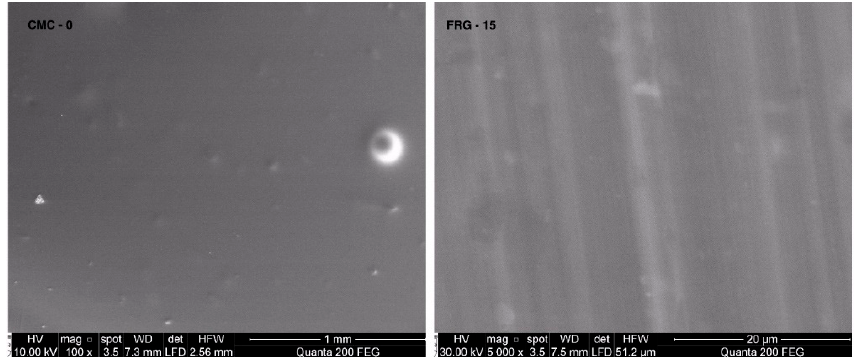
Figure 1. Scanning electron micrographs of films loaded with GFD (FRG—15 sample containing 0.4 g of GFD, 0.3 g of glycerol and 2 g of 2% CMC and without GFD CMC—0—the film sample containing 0.3 g of glycerol and 2 g of 2% CMC.